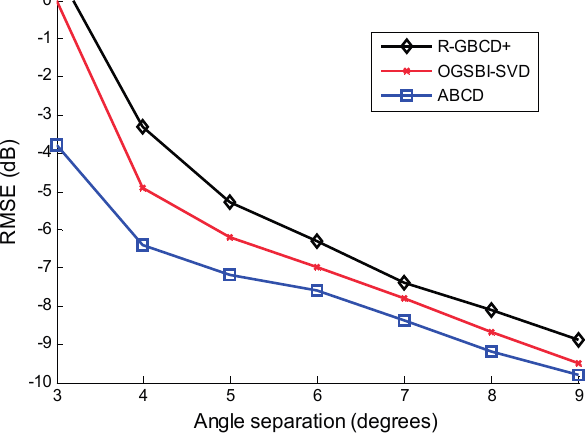
Figure 6. RMSE vs. angle separation with the fixed SNR 0 dB and number of snapshots 100 for coherent